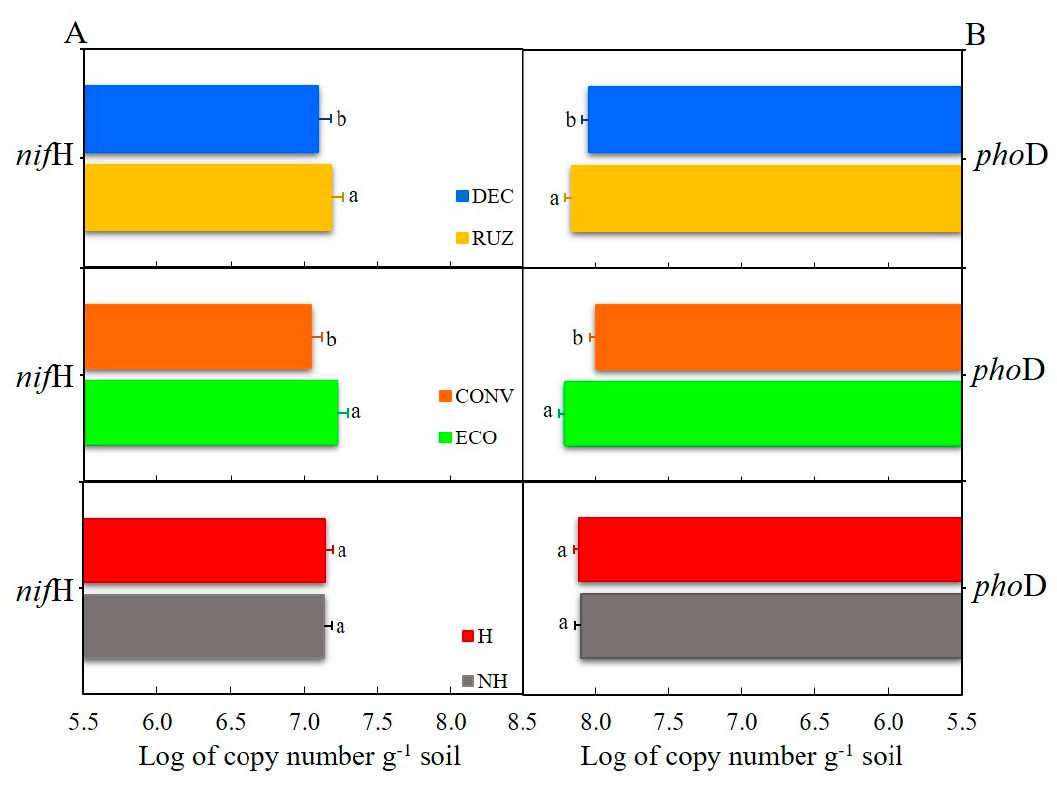
Figure 5. Abundance of the nitrogen fixer enzyme gene, nif H ( A ) and alkaline phosphatase, pho D ( B ) from the rhizosphere of Tahiti acid lime plants tested with different cover crops, mowers, and the use of glyphosate (Mogi Mirim, São Paulo, 2019). Legend: RUZ = Urochloa ruziziensis , DEC = U. decumbens , ECO = ecological mower, CONV = conventional mower, H = glyphosate herbicide (1080 g ae. ha − 1 ), and NH = no herbicide. The significant difference was accounted for by the Tukey test ( p < 0.05), and the error bars represent the minimal significant difference.